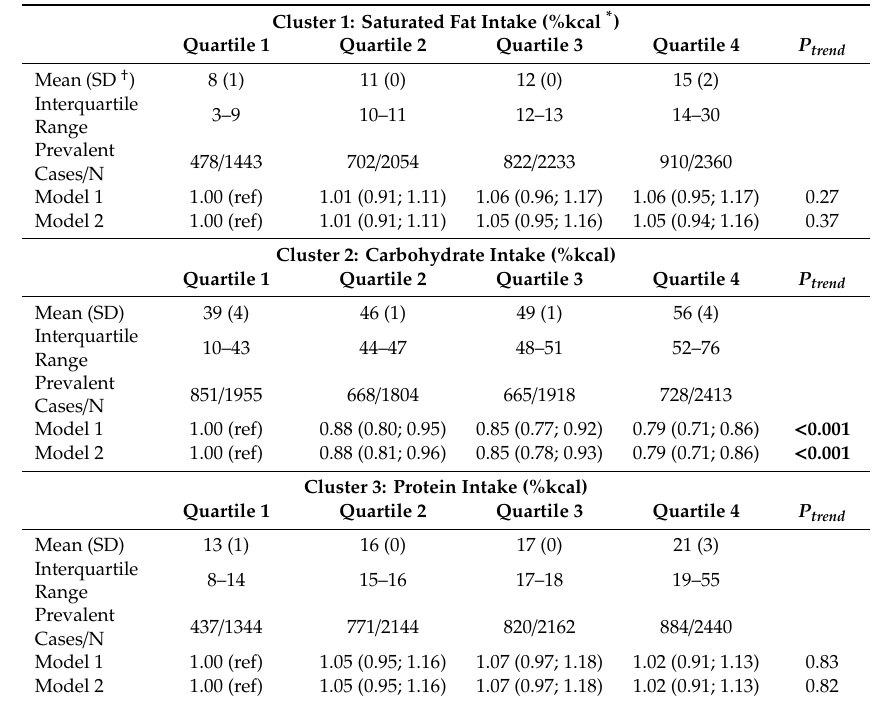
Table 2. Cross-sectional associations between k-means three-cluster solution top hit diet exposure quartiles with cardiometabolic risk prevalence ( N = 8090). Values are presented as prevalence ratio (95% confidence interval). Significant p-values ( p < 0.05) are marked in